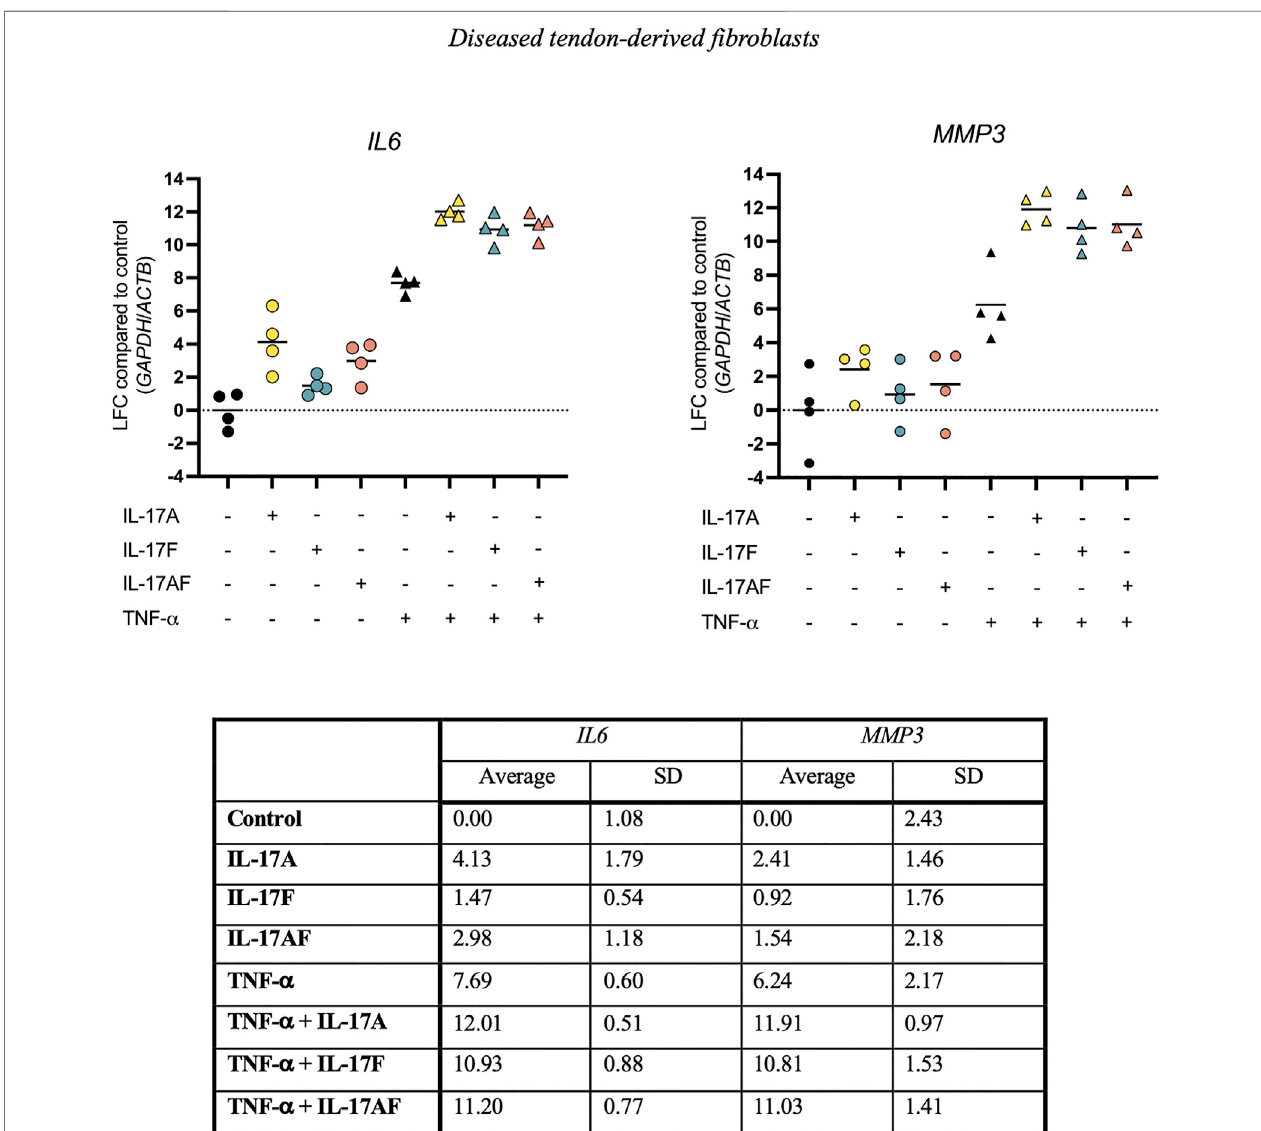
FIGURE 5| Changes in IL6 and MMP3 mRNA expression after treatment with IL-17A, IL-17F, or IL-17AF aloneor in combination with TNF- α in fi broblastsderived from diseased supraspinatus tendons with large or massive tears. mRNA expression was calculated using the ddCT-method using the reference genes GAPDH and ACTB , and is expressed as log2 fold change (LFC) compared to control. Individual values and mean. N (cid:1)